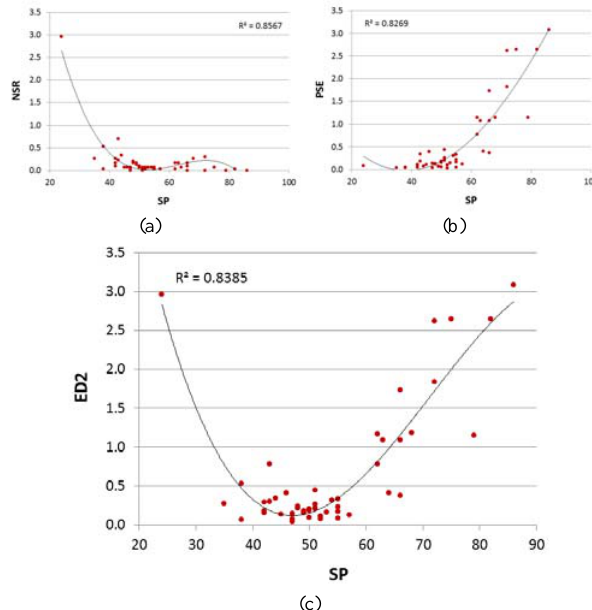
Figure 6. Scattergrams showing the variation with scale parameter (SP) of number-of-segmentation ratio (NSR) (a), potential segmentation error (PSE) (b) and Euclidean distance 2 (ED2) (c), for R1 and R2 subareas.